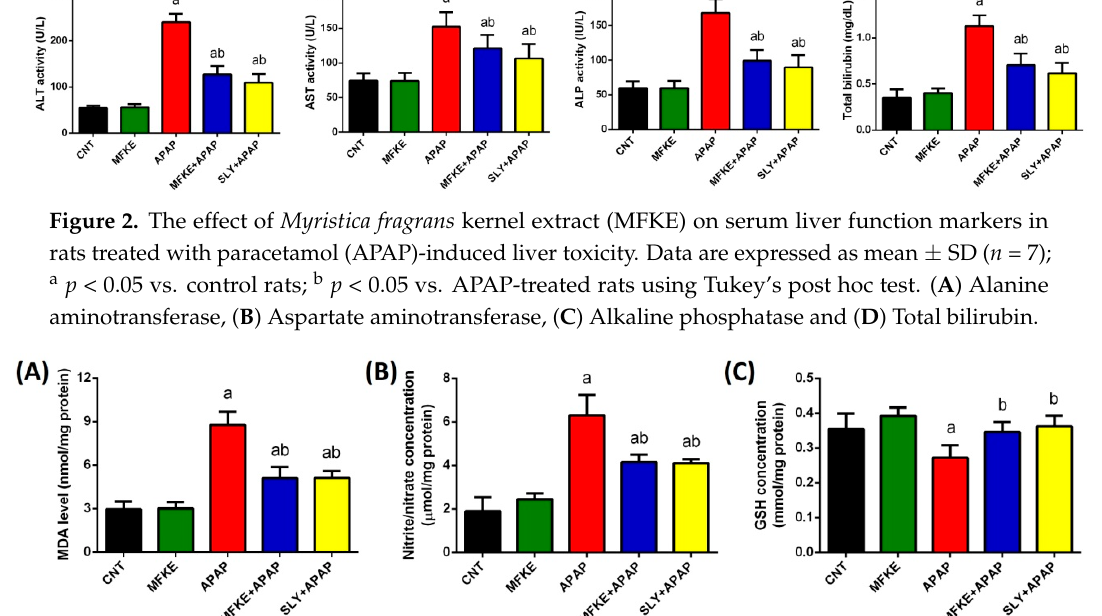
Figure 3. Effects of Myristica fragrans kernel extract (MFKE) on oxidative stress markers in rats treated with paracetamol (APAP)-induced liver toxicity. Data are expressed as mean ± SD ( n = 7); a p < 0.05 vs. control rats; b p < 0.05 vs. APAP-treated rats using Tukey’s post hoc test. ( A ) lipid peroxidation, ( B ) nitric oxide, and ( C ) glutathione.